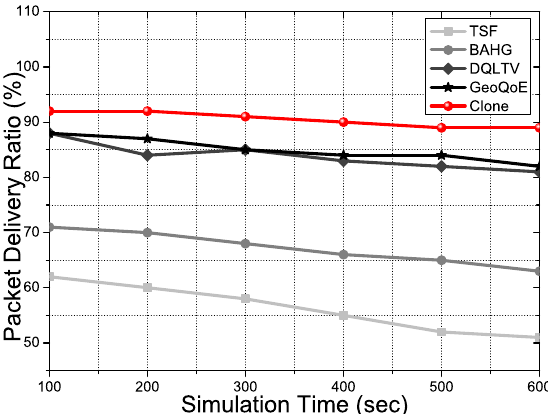
Figure 5. Packet delivery ratio of the overall simulation time.